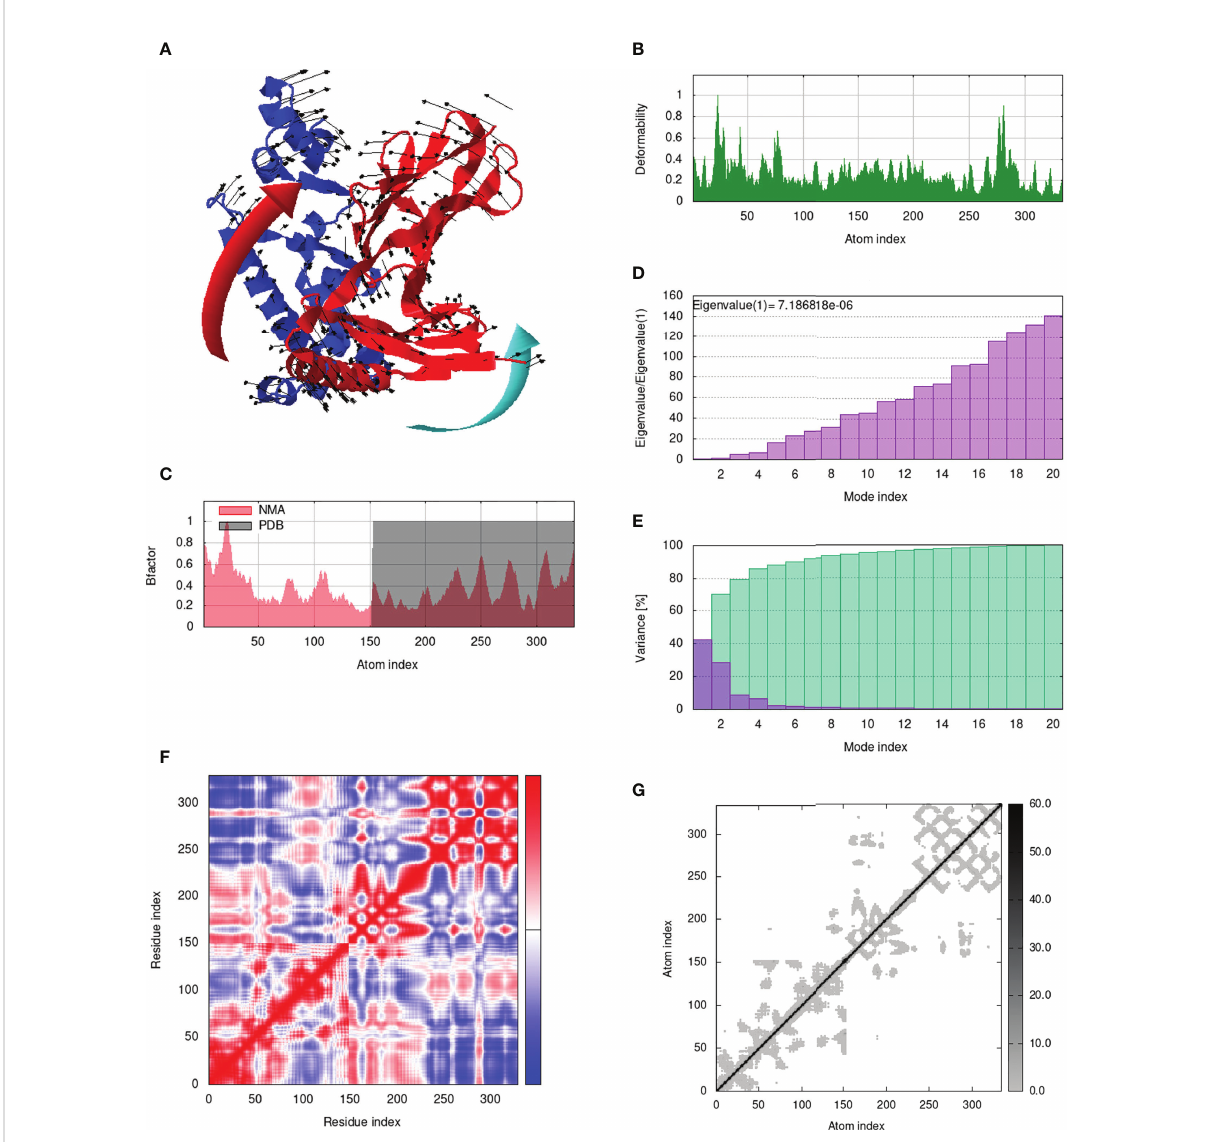
FIGURE 10 Analysis of the vaccine-MHC II complex in normal mode. (A) Structural strength of the re fi ned protein-protein complex mobility; (B) deformability in relation to atoms; (C) B-factor in relation to atoms; (D) eigenvalue in relation to modes; (E) Structural variance; (F) covariance in relation to residue; (G) elastic network in relation to